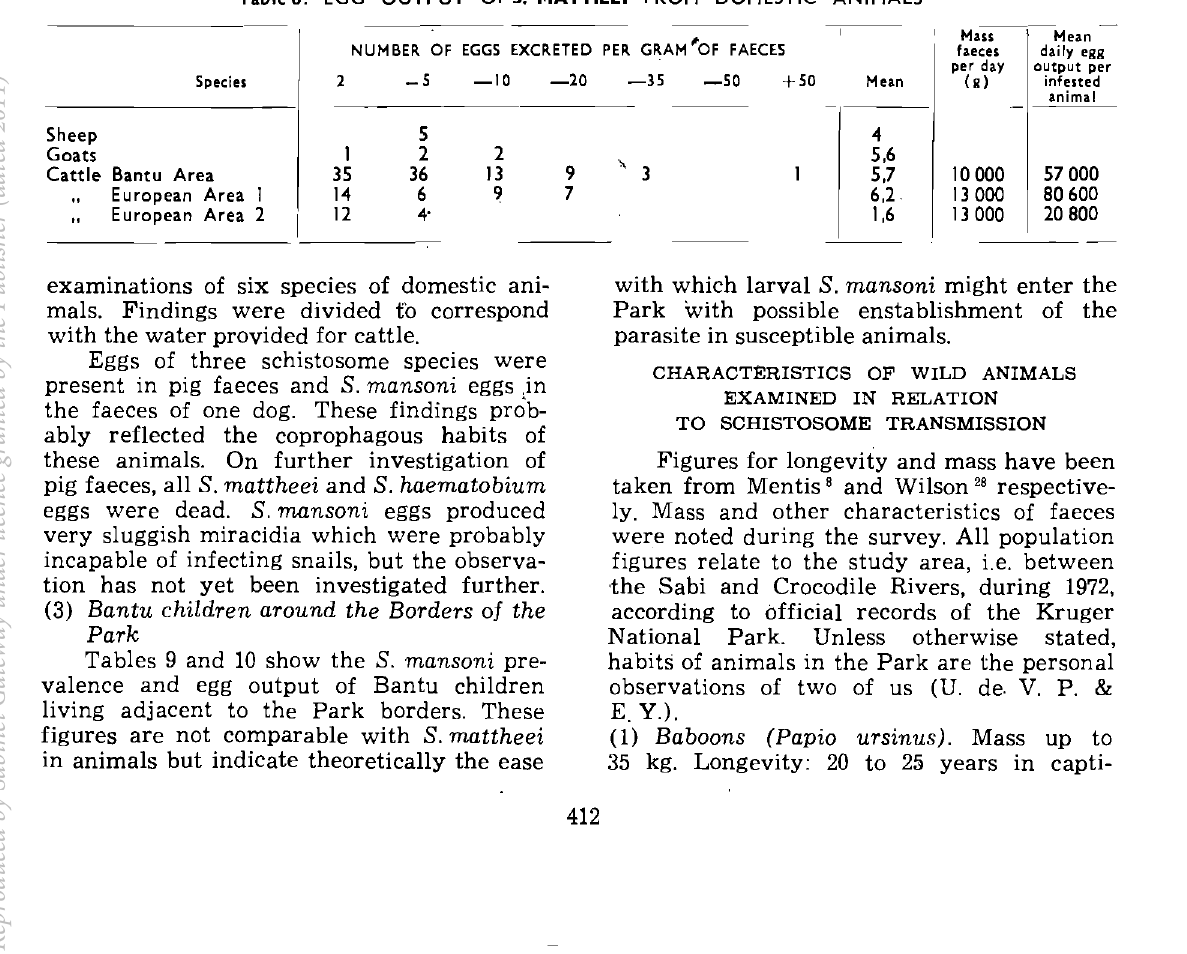
Table 8: EGG OUTPUT OF 5. MATHEEI FROM DOMESTIC ANIMALS NUMBER OF EGGS EXCRETED PER GR,AM"OF FAECES